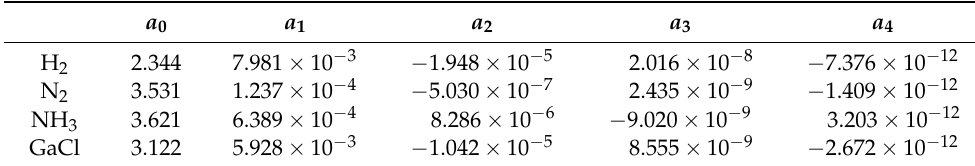
Table A3. Coefficients for C low p for each species.